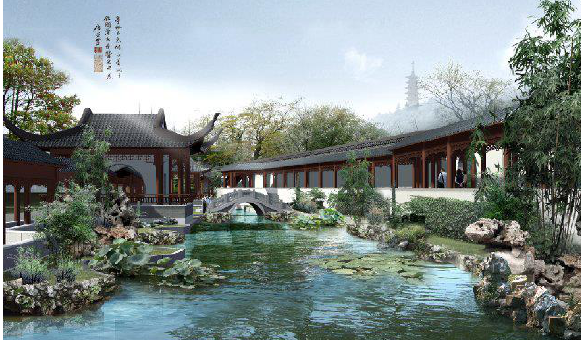
Figure 19. Suzhou Fuyuan communal garden ( 塔影园 ) in its classical style at the forefront of the villa estate. Source: Suzhou Guardian Real Estate Development Co. 2007.